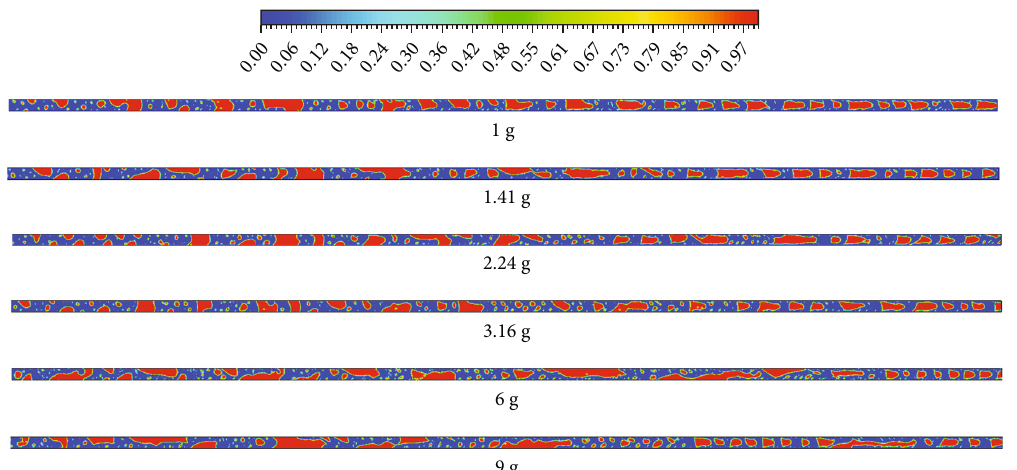
Figure 8: Diagram of boiling fl ow patterns of 0.05% nano fl uid at gravity levels from 1g to 9 g (The gravity direction is the same as the fl ow